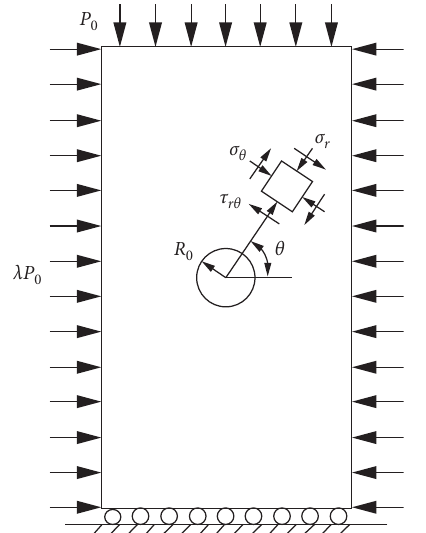
Figure 1: Geometric loading condition.